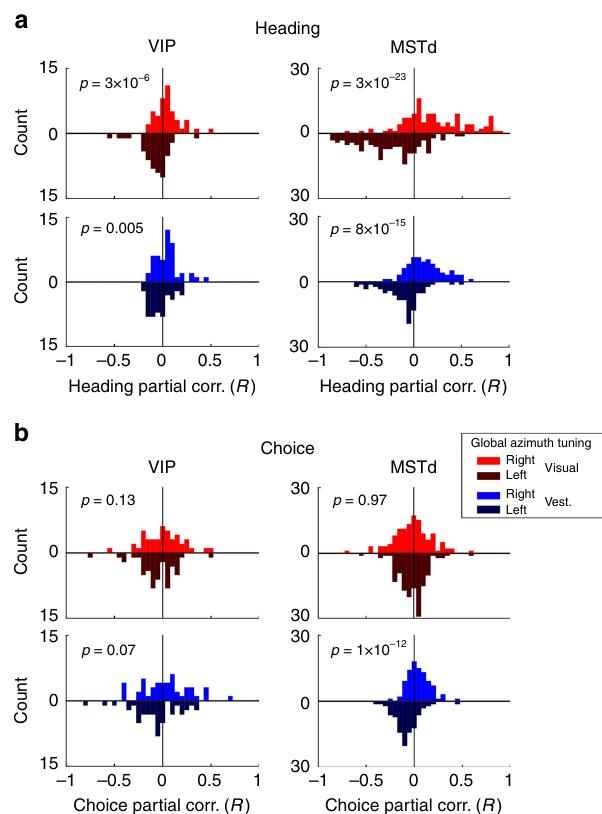
Fig. 7 Heading, but not choice, partial correlations are predicted by heading preferences measured during fi xation. ( a ) Heading and b choice partial correlation histograms are presented for the data with rightward and leftward global heading tuning preferences ( lighter-colored upward histograms, and darker-colored downward histograms, respectively). The data are presented separately for VIP and MSTd ( left and right columns, respectively) and visual and vestibular conditions ( red and blue shades, respectively). p -values (Wilcoxon rank sum tests) are presented on the plots. N = 93 for VIP visual (49 classi fi ed ‘ Left ’ and 44 classi fi ed ‘ Right ’ ), N = 92 for VIP vestibular (45 classi fi ed ‘ Left ’ and 47 classi fi ed ‘ Right ’ ), N = 265 for MSTd visual (141 classi fi ed ‘ Left ’ and 124 classi fi ed ‘ Right ’ ), and N = 265 for MSTd vestibular (124 classi fi ed ‘ Left ’ and 141 classi fi ed ‘ Right ’